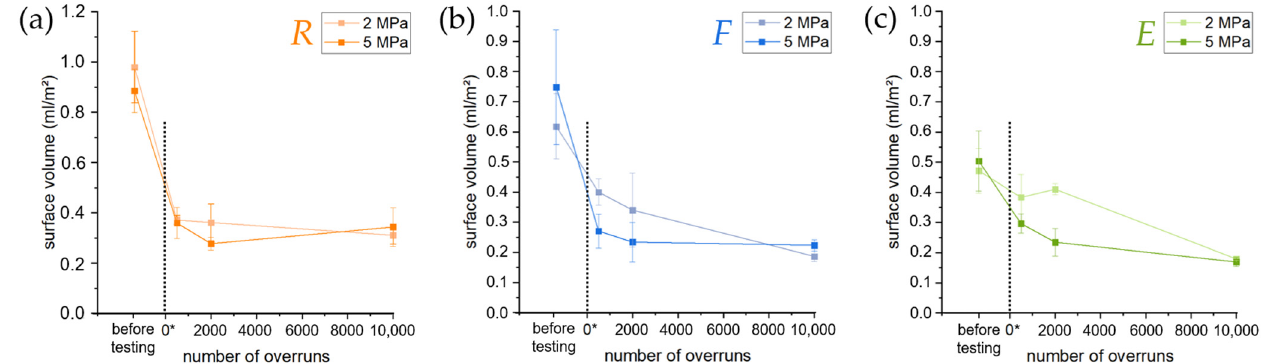
Figure 9. The surface volume as new surface characteristic shows changes with the increasing number of overruns. While the surface R ( a ) indicates no significant difference between preconditioned surfaces tested under LP and HP , surfaces F ( b ) and E ( c ) show smaller V Surf values after testing with HP . For surface R , no clear changes in surface volume are observed after 0*. For surfaces F and E , the surface volume slightly decreased with the increasing number of overruns. Note that the scale of ( a ) differs from that of ( b , c ).